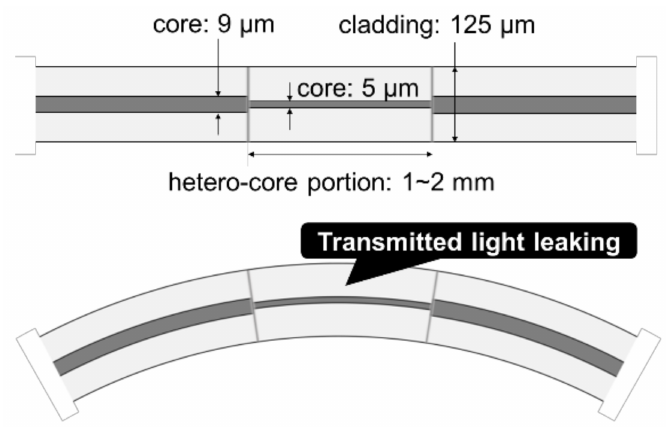
Figure 1. Schematics of a hetero-core fiber optic